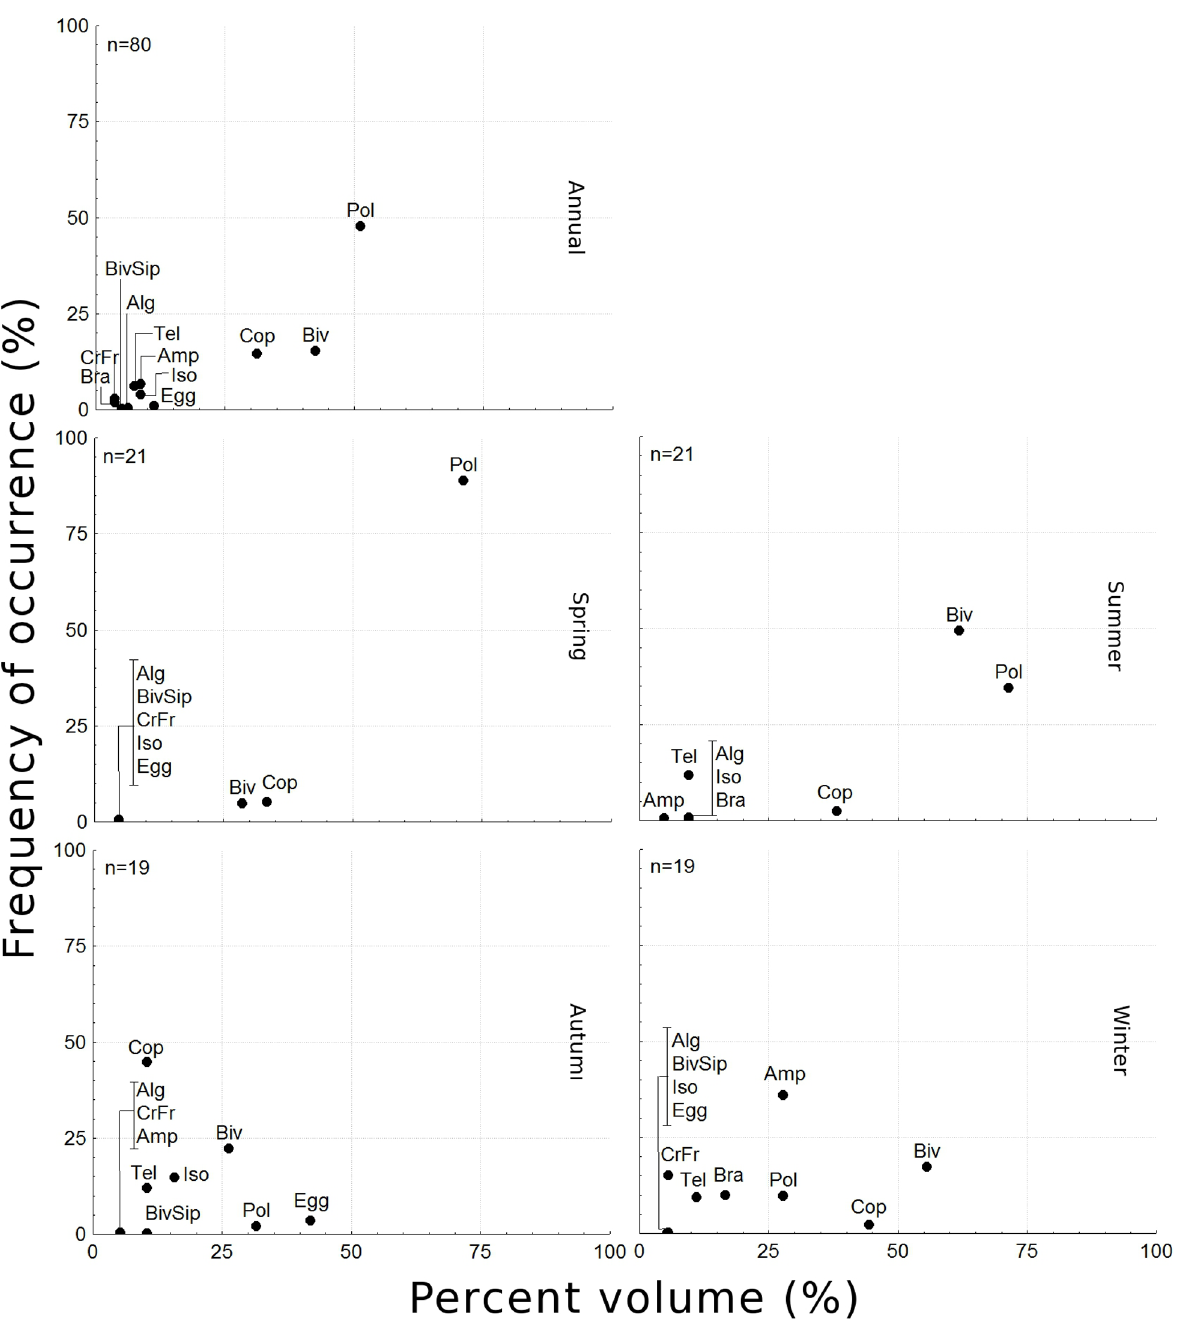
Figure 6. Weight versus frequency of occurrence of each prey group. Weight percentage (W%) and frequency of occurrence (FO) of each prey group found in the stomach contents of Cathorops spixii collected in Caraguatatuba Bight from August 2003 through October 2004. Composition is shown by season and overall. Abbrev. : Polychaeta (Pol), Bivalvia (Biv), Copepoda (Cop), Amphipoda (Amp), Isopoda (Iso), Teleostei (Tel), unidentified crustacean fragments. (CrFr), Bivalvia siphons (BivSip), Algae